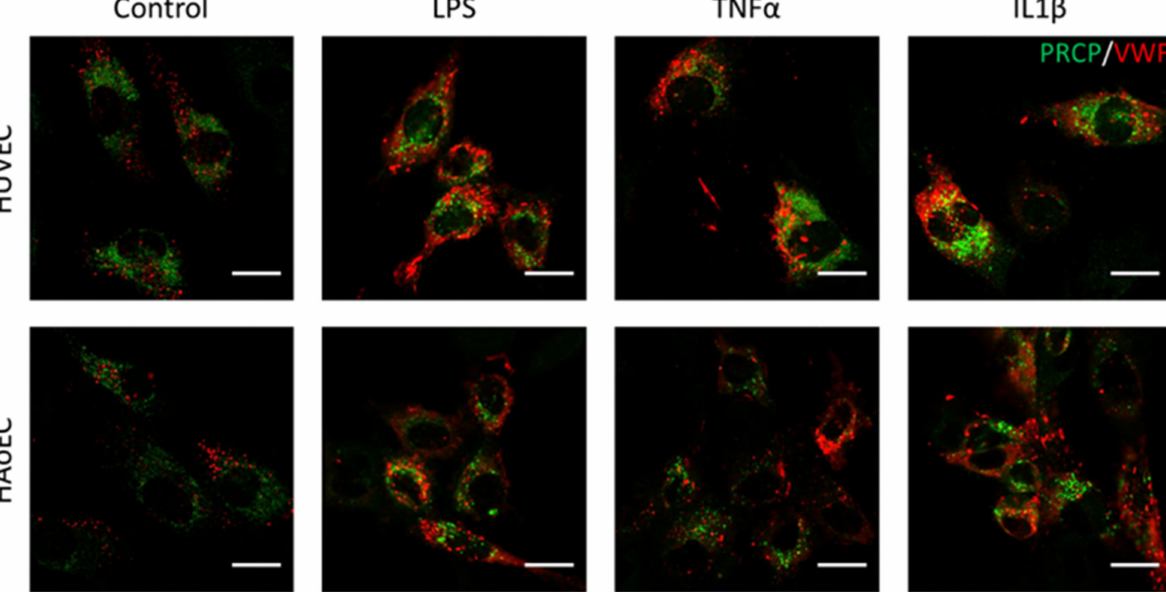
Figure 7. PRCP did not show overlap with vWF in stimulated HUVEC and HAoEC. Double staining of PRCP and VWF in control, LPS-, TNF α -, and IL-1 β -stimulated HUVEC. Cells were incubated for 16 h with the different stimuli, fixed with 4% PFA, permeabilized with 0.1% Triton X-100 and stained for PRCP (green) and vWF (red). Representative images of two independent experiments. (bar = 20 µ